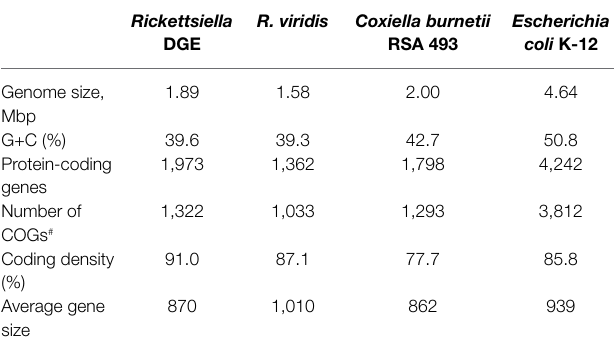
TABLE 1 | General genomic features of Rickettsiella DGE and allied